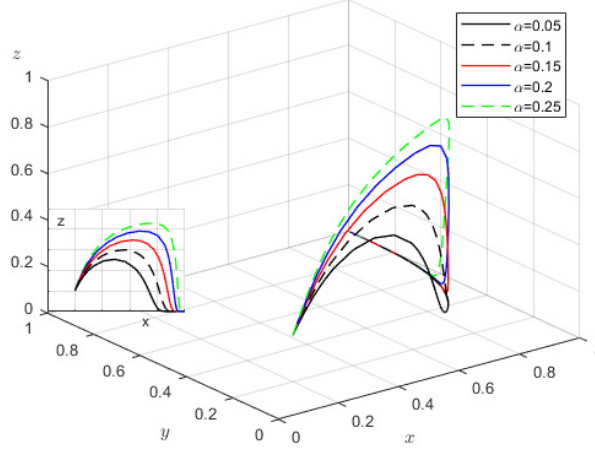
Figure 6. The impact of the community planner.